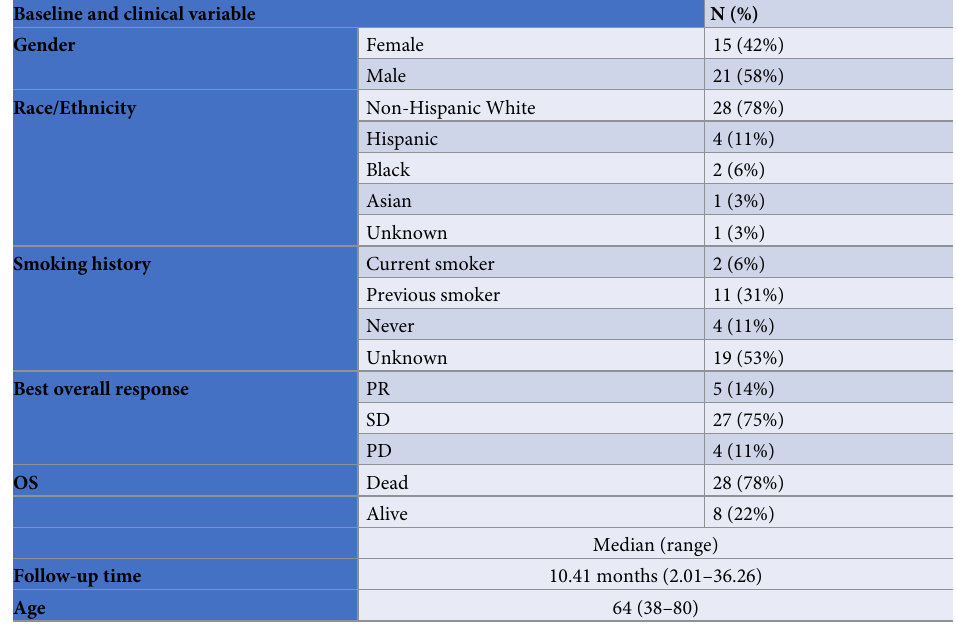
Table 1. Demographic characteristics of 36 patients with stage 4